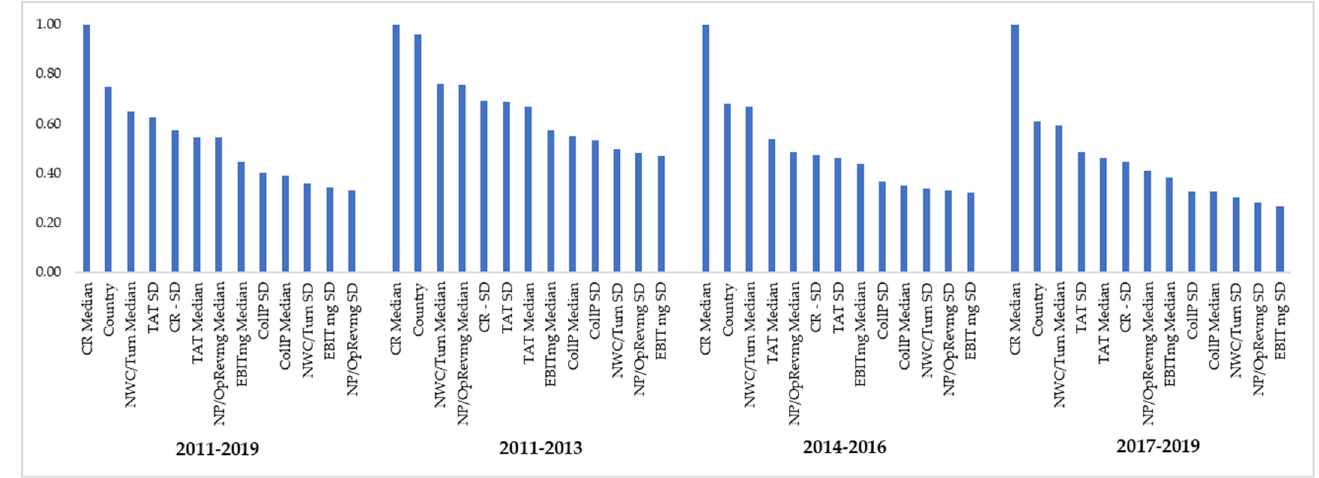
Figure 3. Predictor importance, entire period, and three sub ‐ periods. Source: STATISTICA output and authors’ represen ‐ tation.